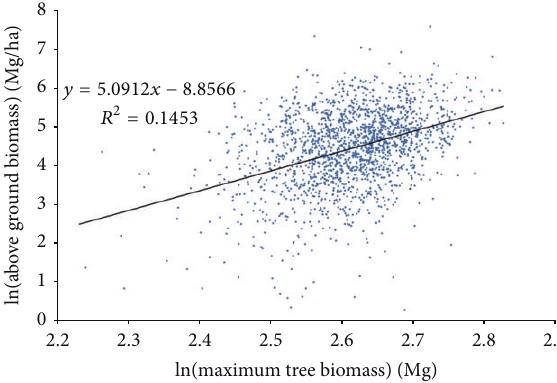
Figure 3: Contribution of the above ground biomass (AGB) of the largest tree per plot and the total AGB of the plot.